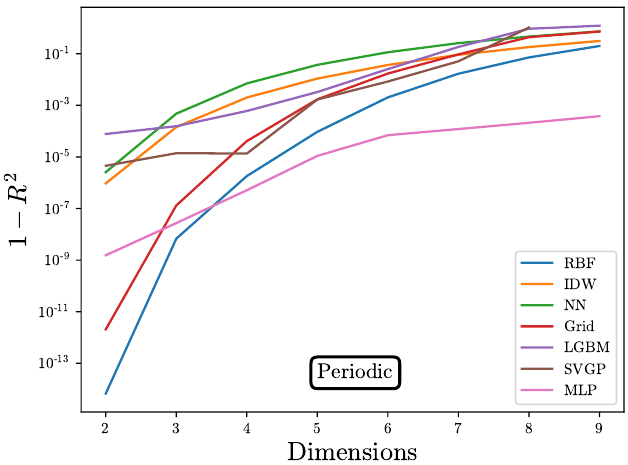
Figure 15: The performance metric 1 − R 2 on the periodic function versus the number of dimensions for all approximants. Lower is better.